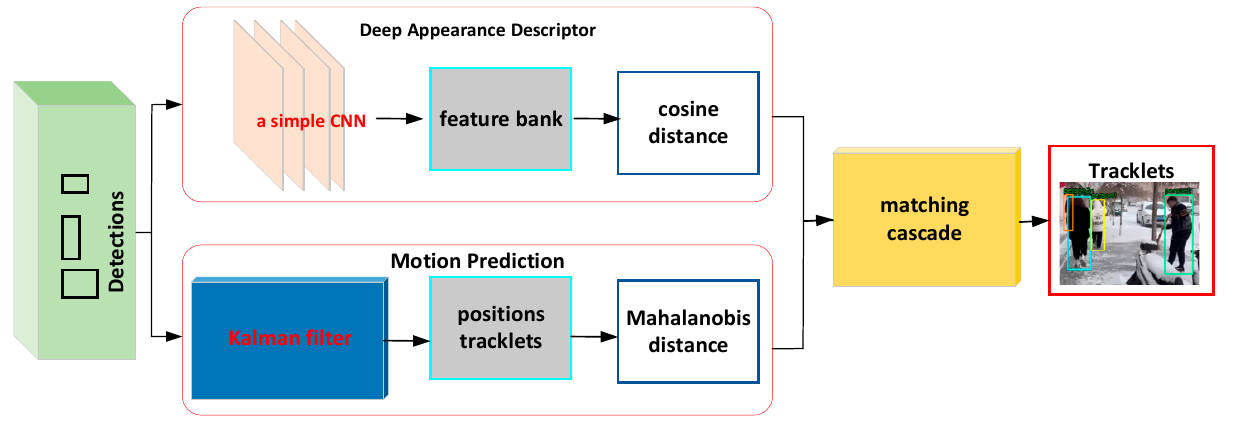
Figure 5. The process of DeepSORT.